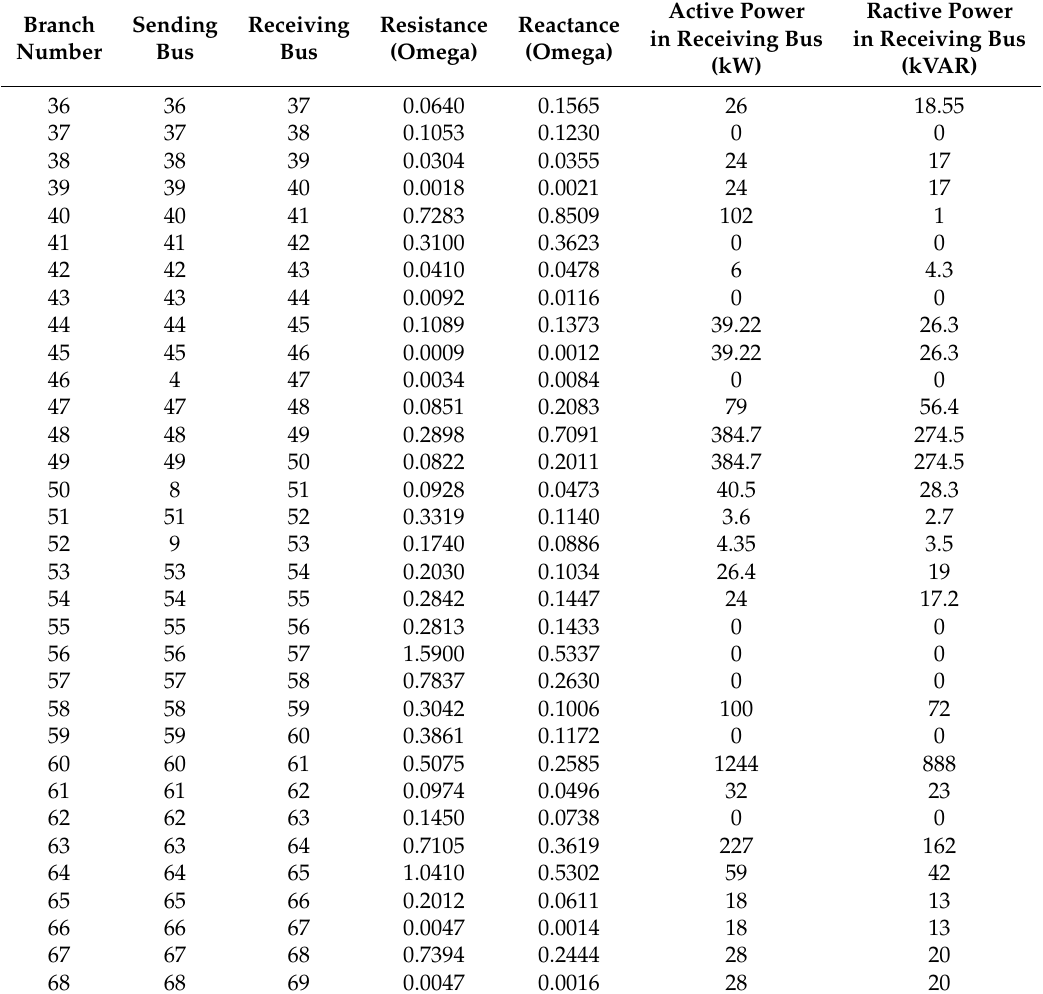
Table A3. Impedance and power of the 66 bus system